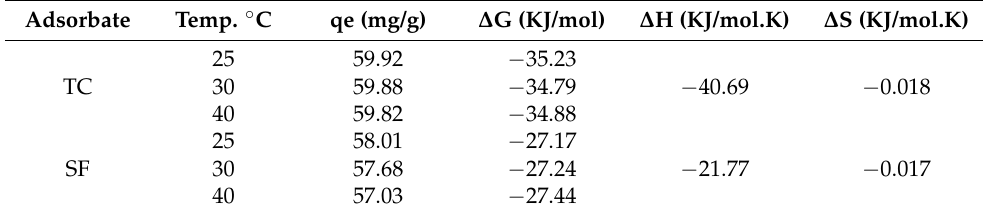
Figure 9. The influence of initial concentration on the adsorption ( A ) equilibrium isotherm, ( B ) Langmuir, ( C ) Freundlich, and ( D ) D-R linear models. Table 3. Different thermodynamic Table 2. Isotherm models for TC and SF adsorption from aqueous media.